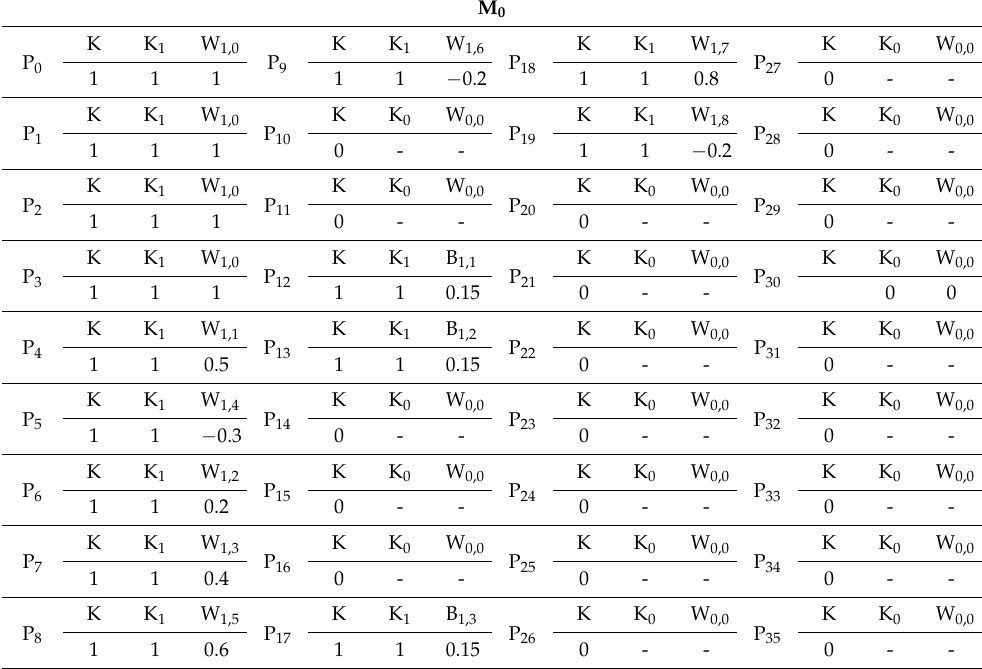
Table 10. Example of the initial